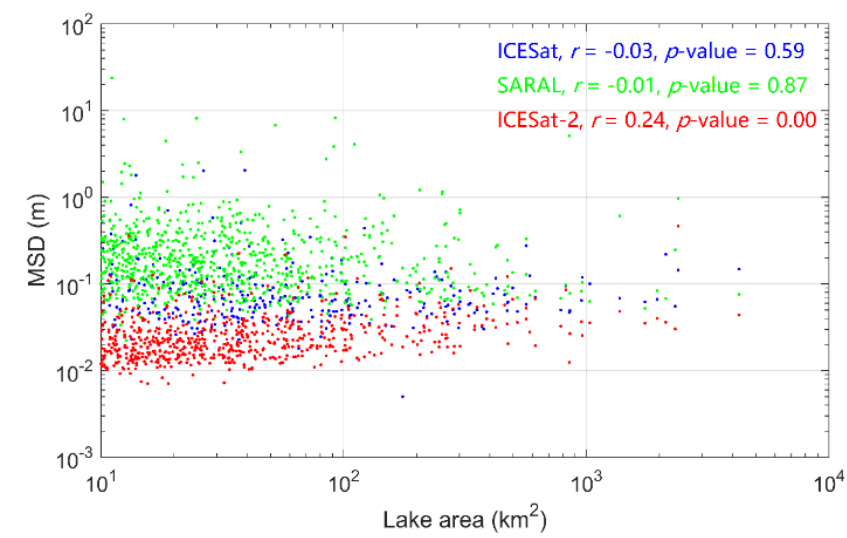
Figure 6. Relationship between MSD and lake (including reservoir) area for different satellites. For the ICESat, SARAL, and ICESat-2, the MSD of all lakes are shown in blue, green, and red dots, respectively. In addition, the correlation relationship of MSD and lake are also indicated by Pearson correlation coefficient ( r ).